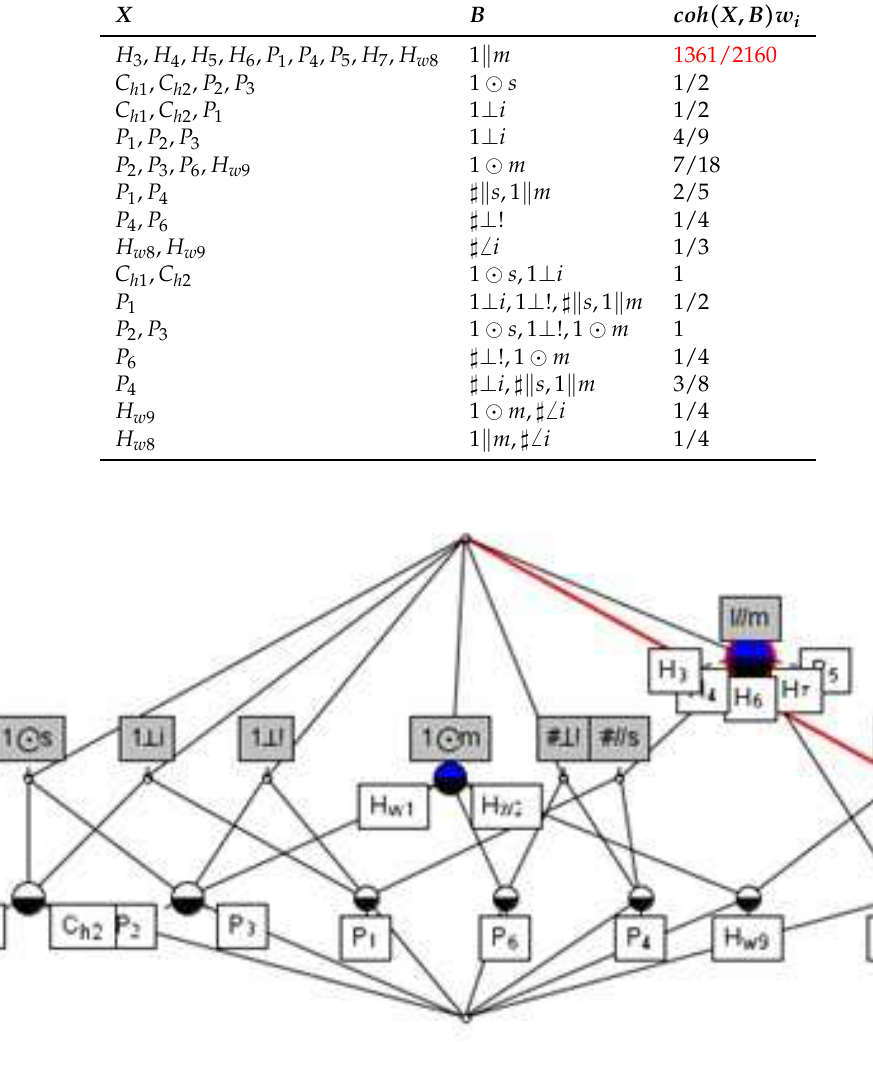
Figure 14. The concept lattice of Table